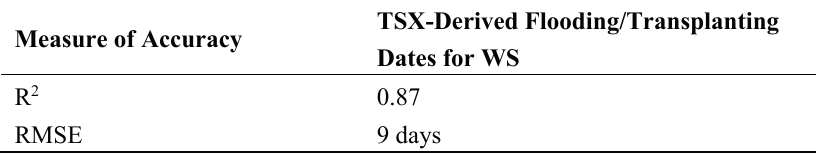
Table 8. Correlation of TSX-derived flooding/planting dates with the ground truth flooding/planting